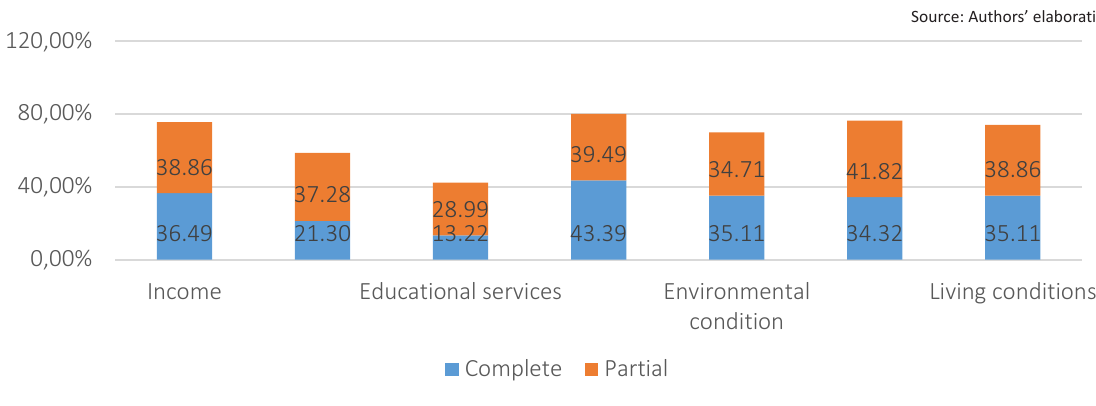
Figure 4. The spread of deprivation components at the territory weighted by the level of positive